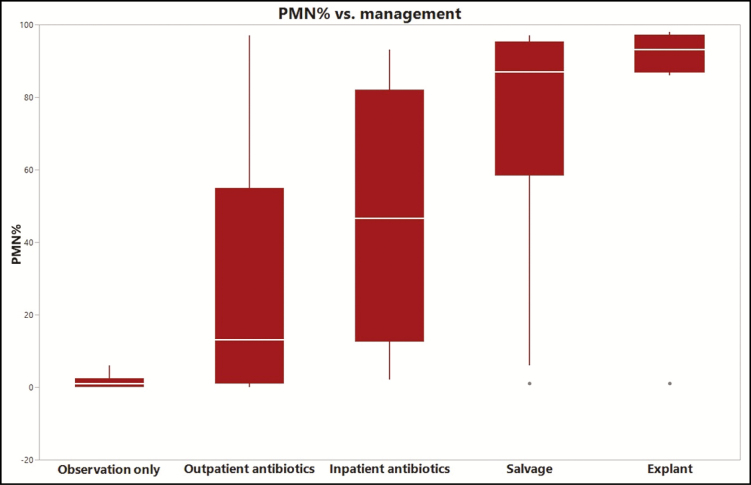
Neutrophil percentage (PMN%) vs associated outcomes.